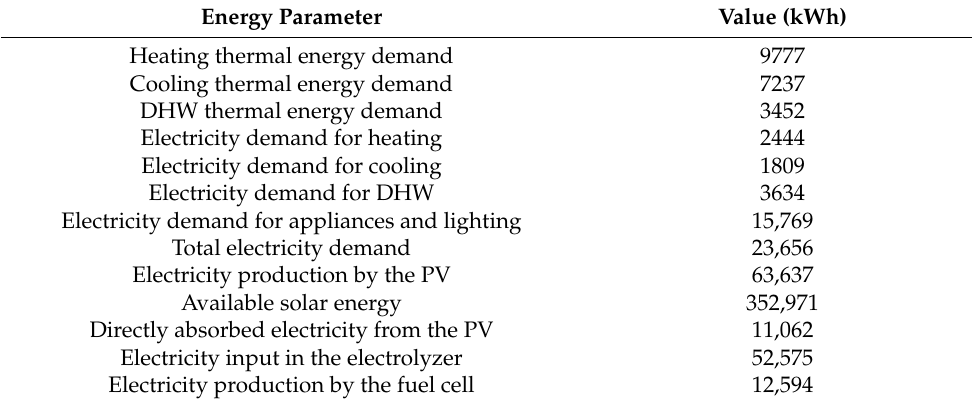
Table 3. Final data of the simulation